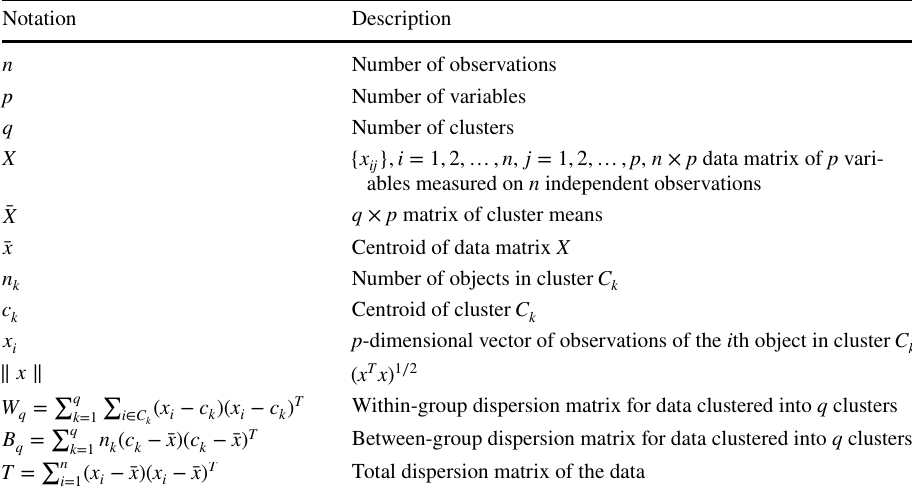
Table 1 Details of notations